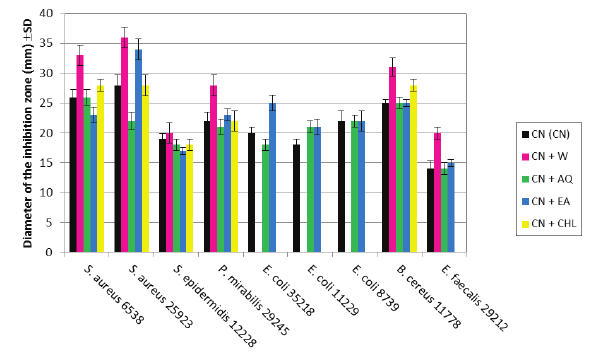
Figure 7: Bacterial strains response to Gentamicin/CN combinations with the four Arctii folium extracts (CN+W, CN+AQ, CN+EA, and CN+CHL) comparatively to the antibiotic alone, CN (C); diameter of the inhibition zone, (mm) ±